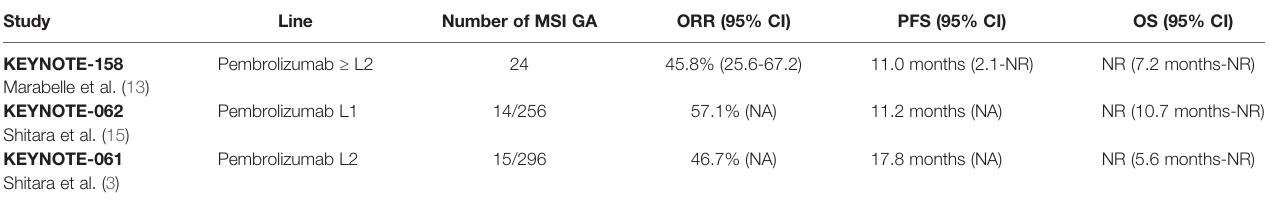
TABLE 1 | Results of MSI-H GA patients treated with ICI